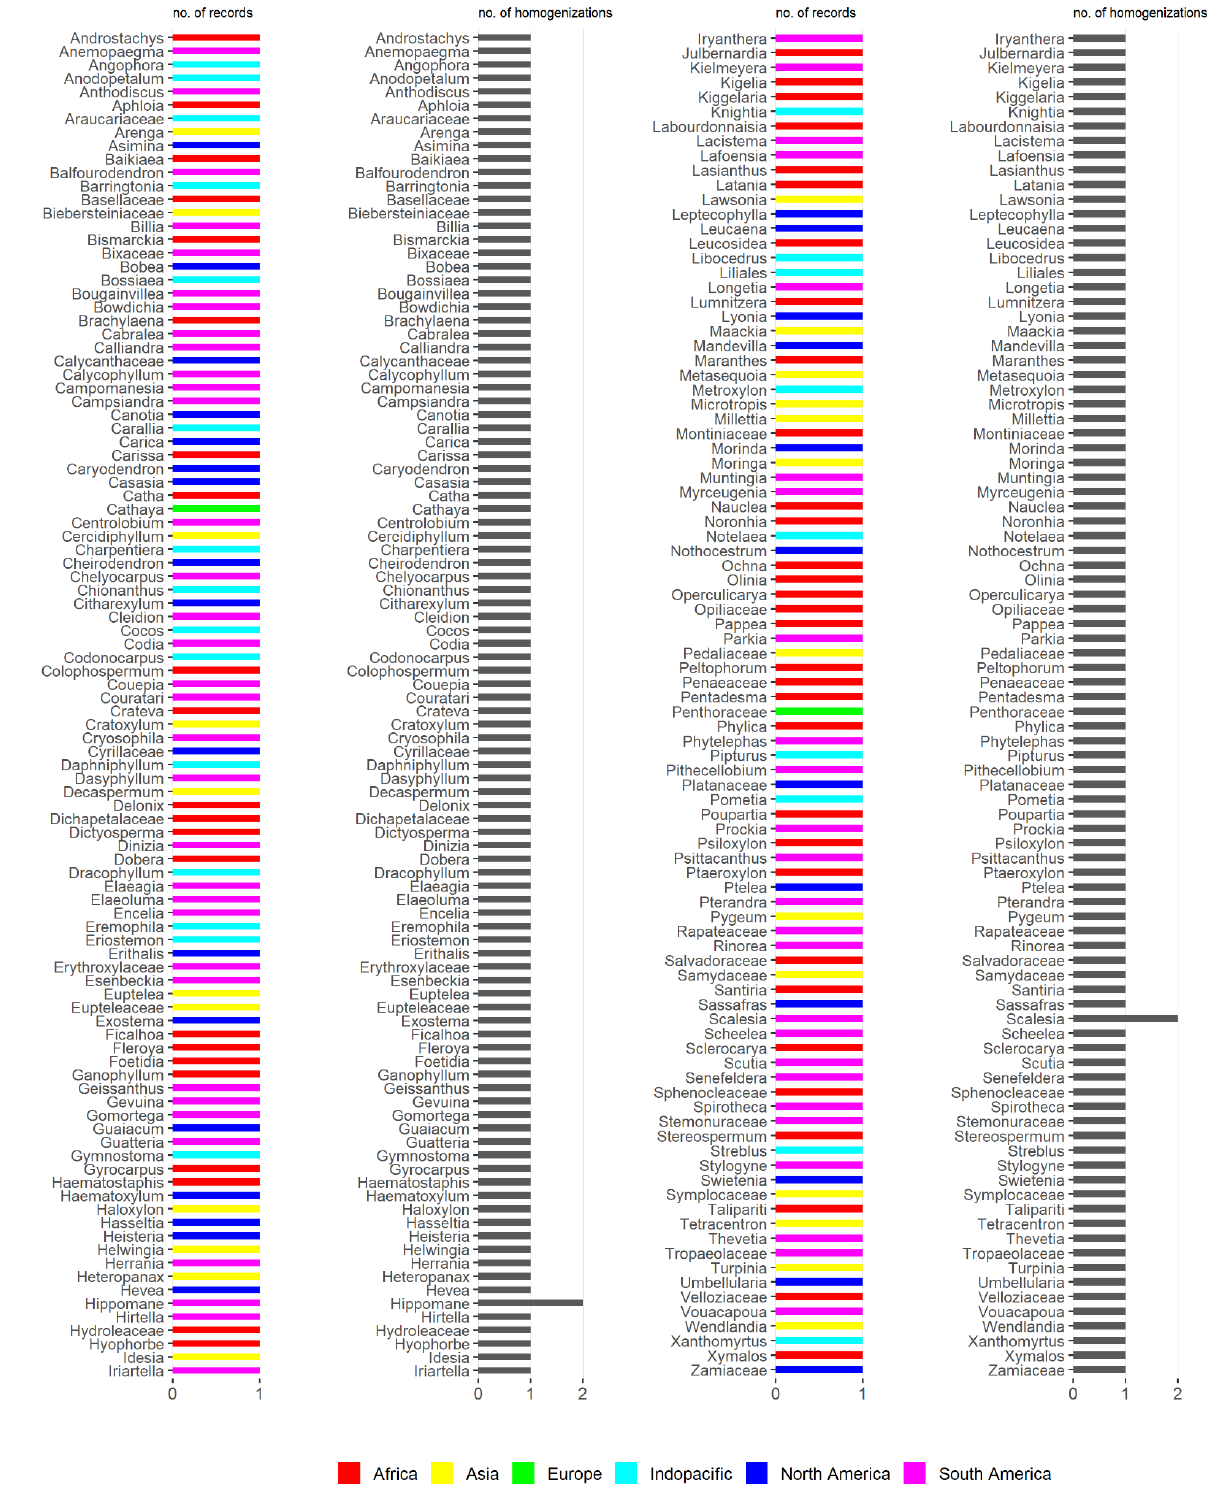
Figure A1. Number of records of each taxon per continent and the number of subsumed variants per harmonized taxon (full taxon list).